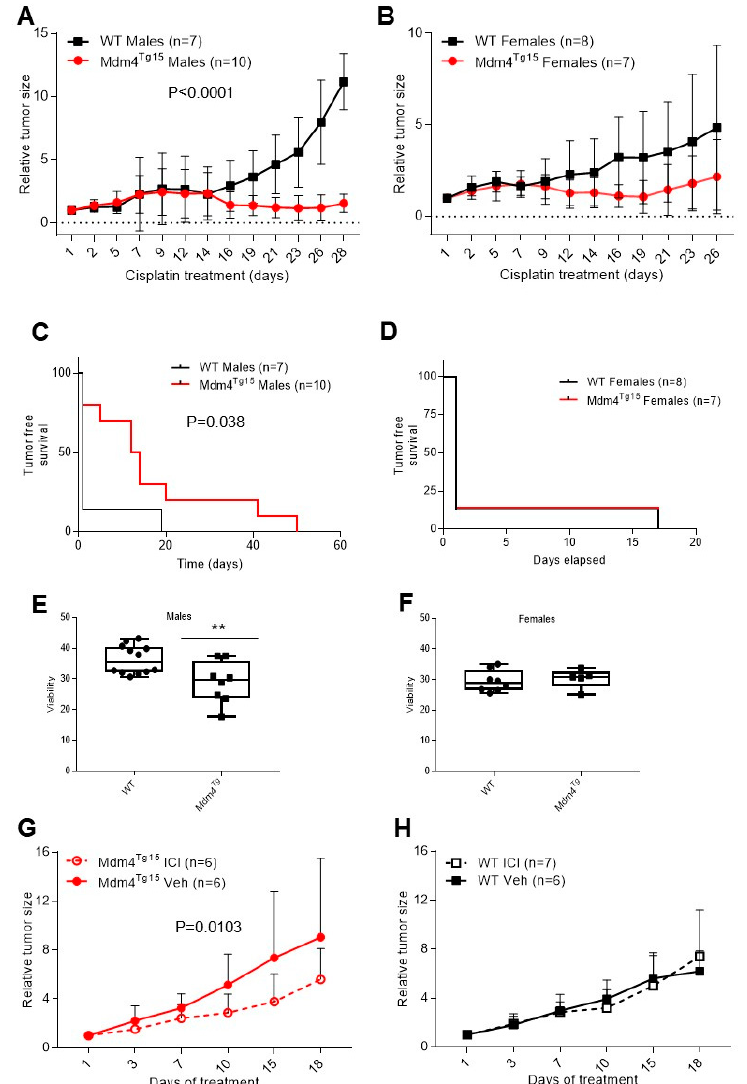
Figure 2. Cisplatin-sensitivity is decreased in transgenic Mdm4 Tg15 females, dependent of the ER α activity. ( A , B ) Growth curve of fibrosarcoma in WT and Mdm4 Tg15 males ( A ) and females ( B ) treated with cisplatin. After reaching a volume of approximately 200 mm 3 , animals were treated bi-weekly with i.p. cisplatin (5 mg / Kg). Tumor size is relative to the volume at the first treatment (two-way ANOVA, ( A ) DF = 12, F (interaction) = 9.109; ( B ) DF = 11, F (interaction) = 1.194). ( C , D ) Tumor-free survival of Mdm4 Tg15 and WT males ( C ) and females ( D ) shown in A and B (Log-rank test ( C ) df = 1, χ 2 = 4.27; ( D ) df = 2, χ 2 = 3031, n.s.). ( E , F ) Thymocyte viability in Mdm4 Tg and WT males ( E ) and females ( F ) subjected to total body 6Gy ɣ -irradiation. After 6 h, mice were sacrificed, thymocytes isolated and analyzed by FACS. Mean ± SD is shown (Two-tailed unpaired t -test, ( E ) n = 20, DF = 18, t = 2.91 p = 0.0093; ( F ) n = 13, DF = 11, t = 0.4482, n.s.). ( G , H ) Fibrosarcoma cisplatin sensitivity in Mdm4 Tg15 ( G ) and WT females ( H ) ± ICI. After reaching a volume of 200 mm 3 , animals were treated with bi-weekly i.p. cisplatin (5 mg / Kg) and weekly s.c. ICI or vehicle (PBS). Tumor size is relative to the volume at the first treatment (two-way ANOVA not RM, ( G ) DF = 1, F (treatment) = 7029; ( H ) DF = 1, F (treatment) = 0003, n.s.).